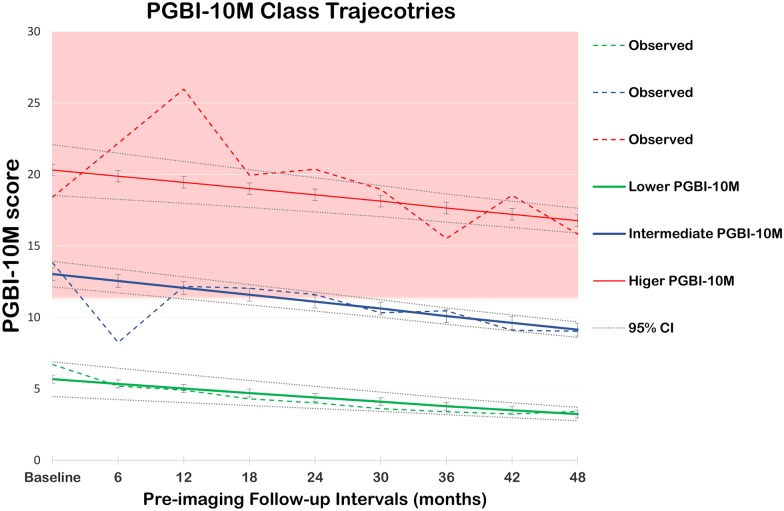
Line plot shows main class-trajectories identified in the 115 LAMS youth study participants.The red line represents the class-trajectory of LAMS youth with initially high and subsequently improving PGBI-10M scores, the blue line represents the class-trajectory of LAMS youth with intermediate PGBI-10 M scores and the green line represents the class-trajectory of LAMS youth with initially low and subsequently improving PGBI-10M scores in the pre-imaging follow-up period (5 years). The pink area represents the clinically significant range of PGBI-10M (>12).